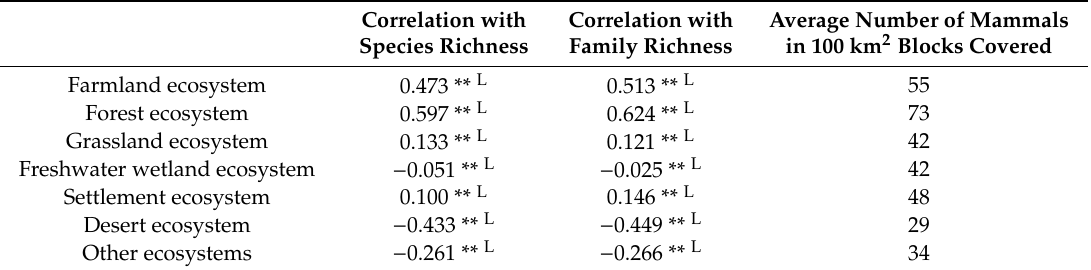
Table 5. Correlation between mammalian richness and ecosystem types, and average number of mammals in 100 km 2 blocks covered by ecosystem types.